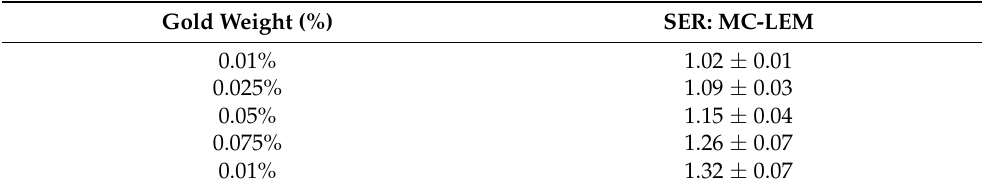
Table 5. Sensitization enhancement ratio (SER) calculated from Figure